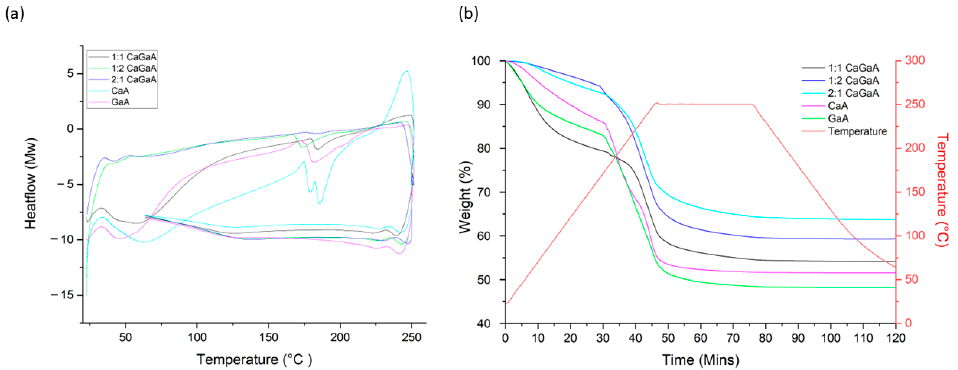
Figure 5. Comparison in ( a ) differential scanning calorimetry (DSC) and ( b ) thermogravimetric (TGA) values for calcium alginate, gallium alginate, calcium gallium alginate 1:1, calcium gallium alginate 1:2 and calcium gallium alginate 2:1.